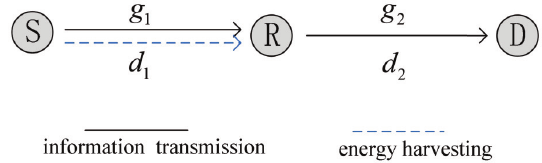
Figure 1. System model of the SWIPT based one-way AF relay network.